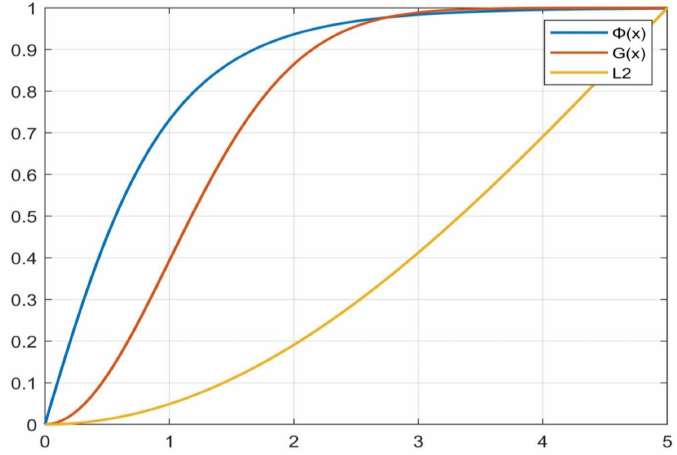
Figure 3. The curves of different penalty functions: The penalty function Φ ( x ) proposed in this study achieved the fastest saturation